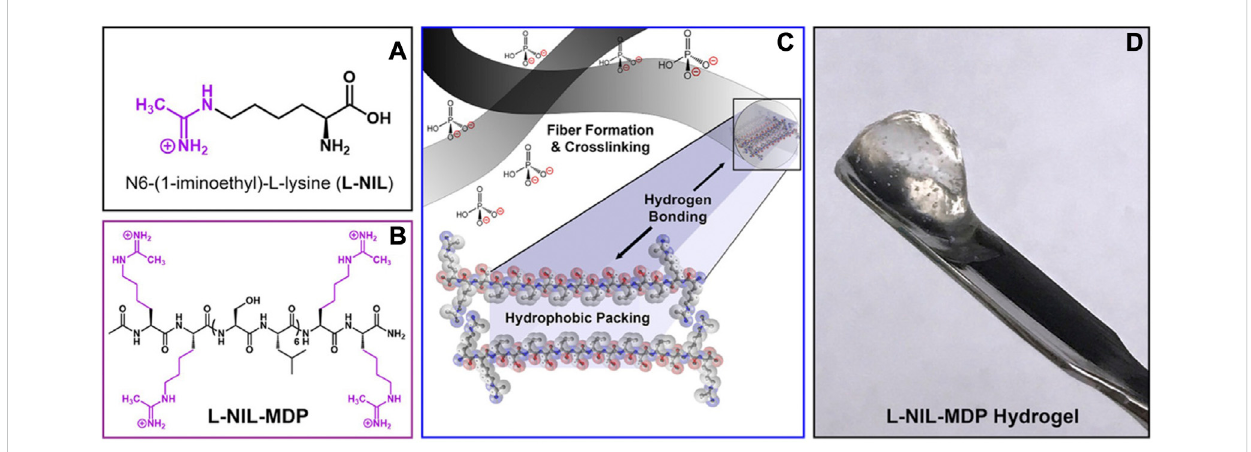
FIGURE 2 Self-assembling peptide chemical structure of N 6 -(1-iminoethyl)-L-lysine (A) Design of L-NIL-MDP. (B) Lysine side chains from starting material, K